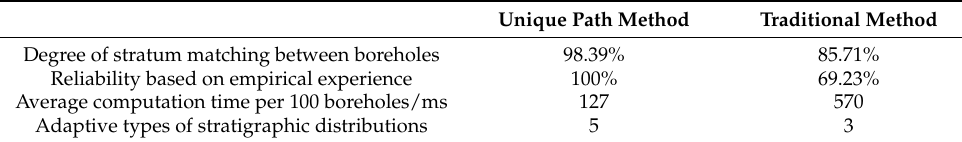
Table 5. Comparison between unique path method and traditional